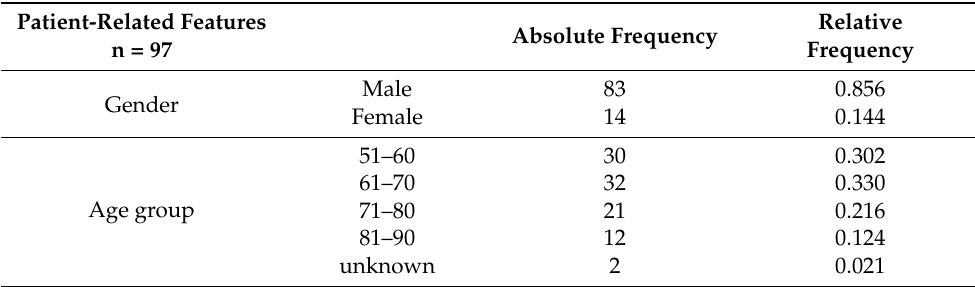
Table 1. Statistical summary of the patient-related features for therapy decision. Patient-Related